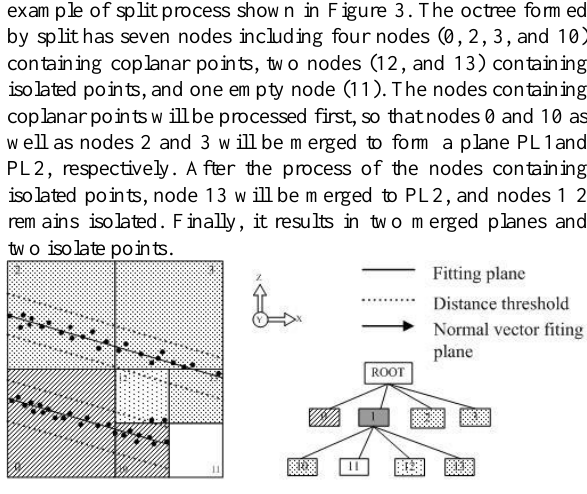
Figure 4. The Octree-based merge process